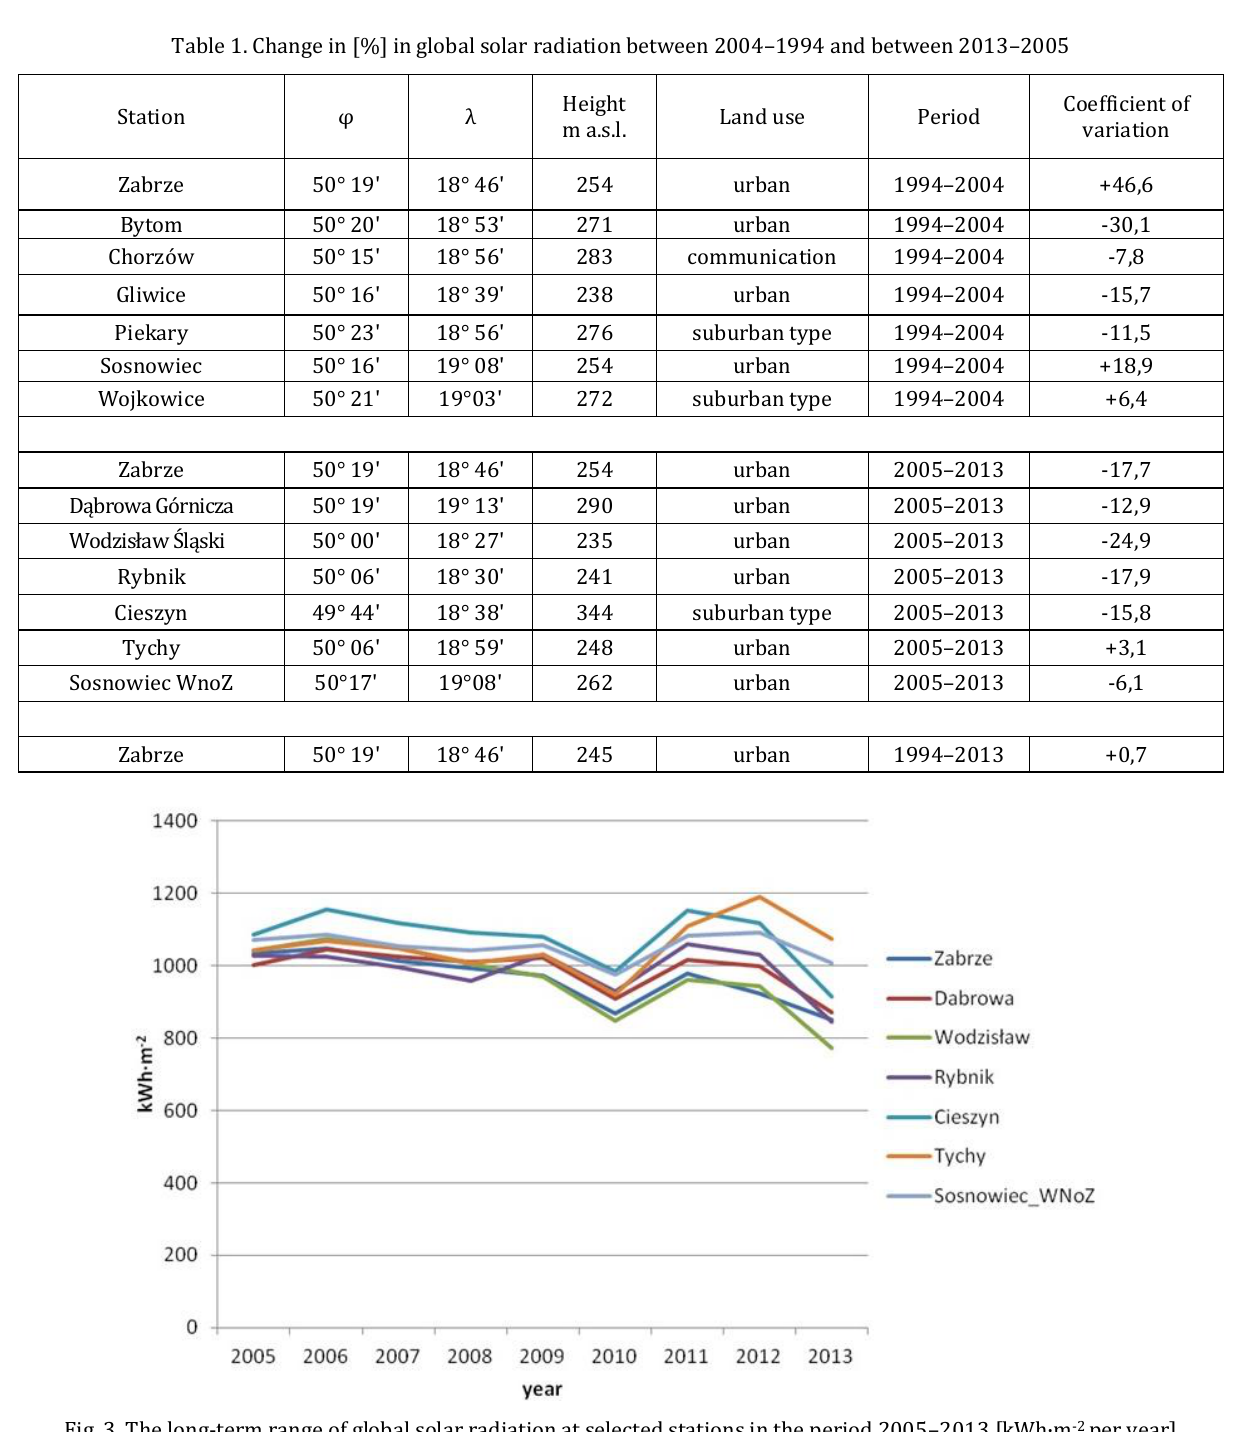
Fig. 3. The long-term range of global solar radiation at selected stations in the period 2005–2013 [kWh·m -2 per